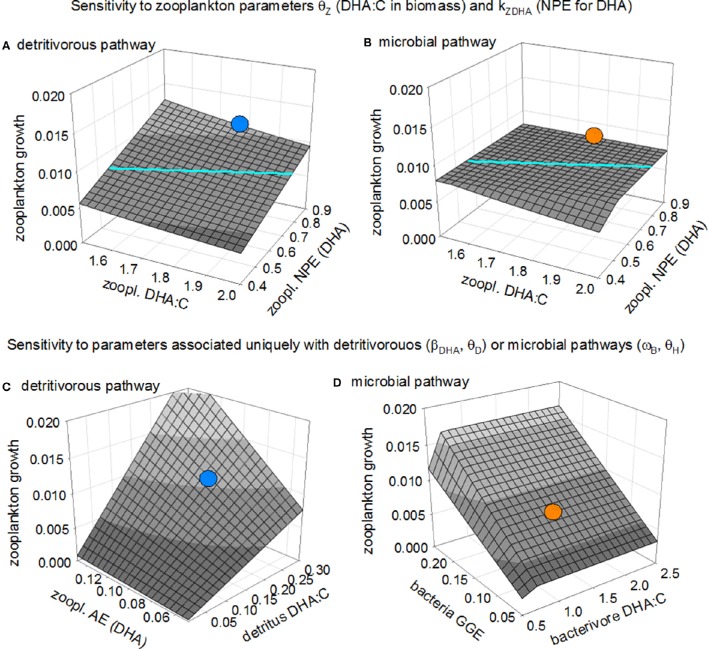
Sensitivity of predicted zooplankton growth to parameters θZ (zooplankton DHA:C ratio; mmol mol−1) and kZDHA (zooplankton NPE of DHA) for the detritivorous and microbial pathways (panels A and B; the colored lines demarcate where the two planes intersect) and sensitivity to key parameters associated with the two pathways: (C) detritivorous pathway, parameters θD (detritus DHA:C ratio) and βZDHA (zooplankton absorption efficiency for DHA in detritus) and (D) microbial pathway, parameters θH (bacterivore DHA:C ratio) and ωB (B GGE). The two blue points indicate predicted growth following the detritivorous pathway as shown in Figure 2, and the two orange points the corresponding predicted growth following the microbial pathway.